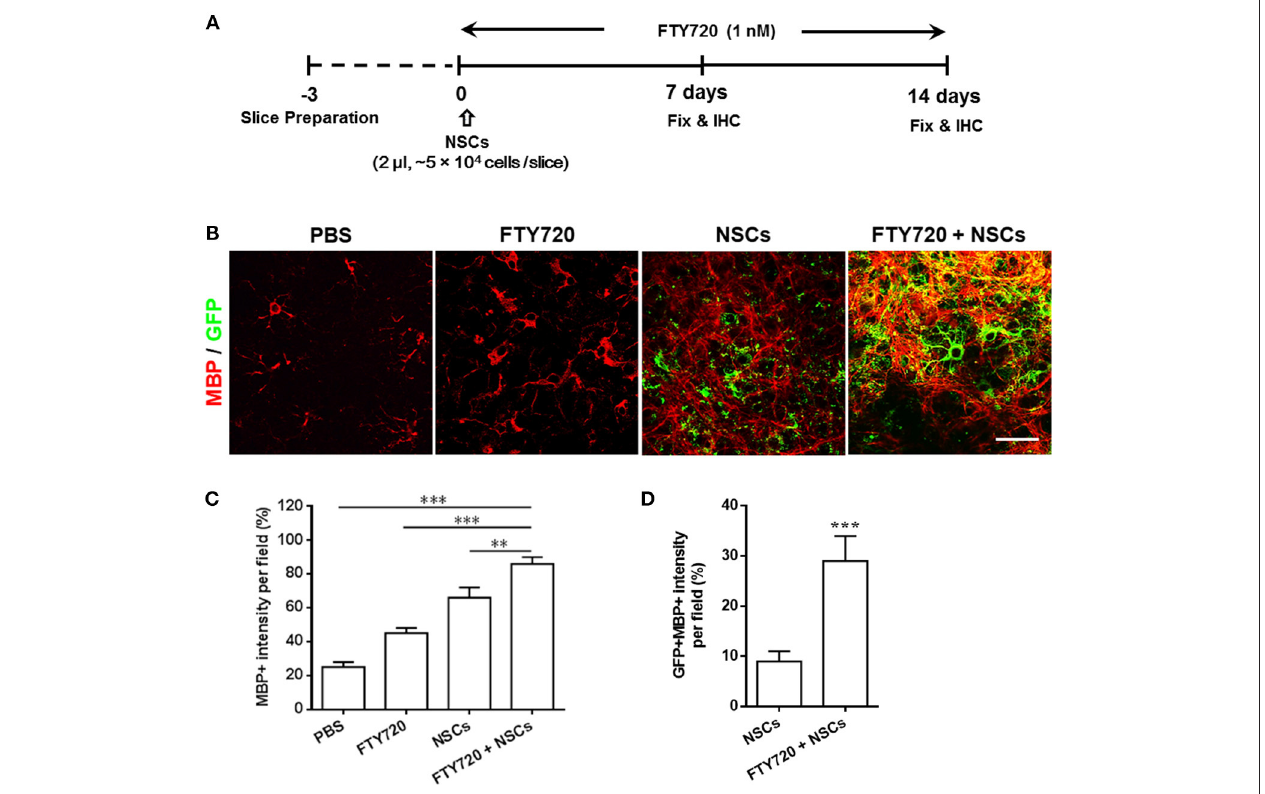
FIGURE 1 | Co-treatment with FTY720 and NSCs promoted myelination in the brain slice culture model. (A) Schematic diagram illustrating experimental design followed throughout this study. Slices obtained from newborn (P0-3) C57/Bl6 mouse pups were grown for 3 days, and NSCs (2 µ l, ∼ 5 × 10 4 cells /slice) and/or FTY720 (1nM) were added for the subsequent 14 days, after which the slices were fixed and immunostained. (B) Representative confocal images displaying GFP + cells (green; NSCs) and MBP (red) immunoreactivity after 14 days of treatment. Scale bar = 20 µ m. (C) MBP intensity was measured using Image-Pro. (D) GFP + MBP + intensity was measured using Image-Pro. Representative images are shown, and quantitative data refer to mean ± SD ( n = 6 slices/group). ** p < 0.01, *** p < 0.001. One-way ANOVA with Tukey’s multiple comparisons test and unpaired Student’s t -test. One representative of 3 independent experiments is shown.